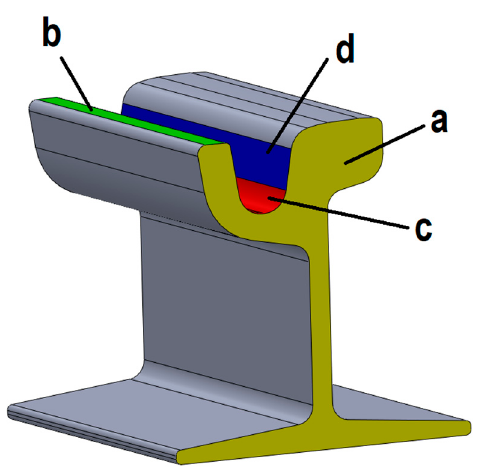
Figure 13. Automated inspection procedure: references for alignment. a : cross-section plane; b : counter rail; c : throat cylinder; d : flange.